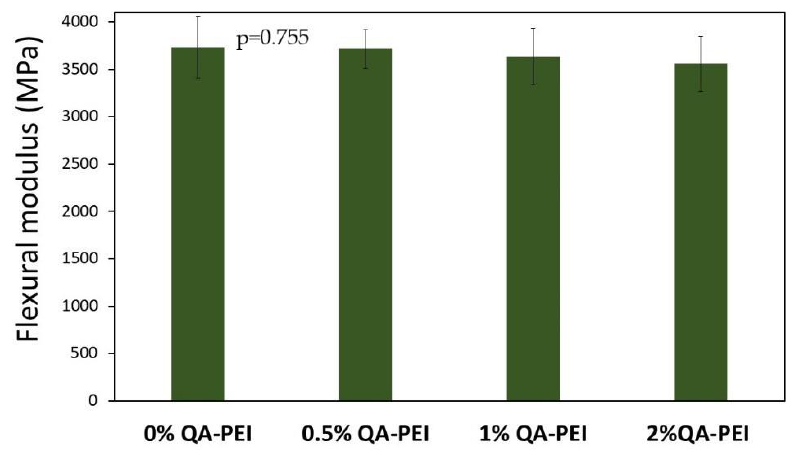
Figure 14. E values of the materials. All the results for E were statistically insignificant ( p > 0.05).